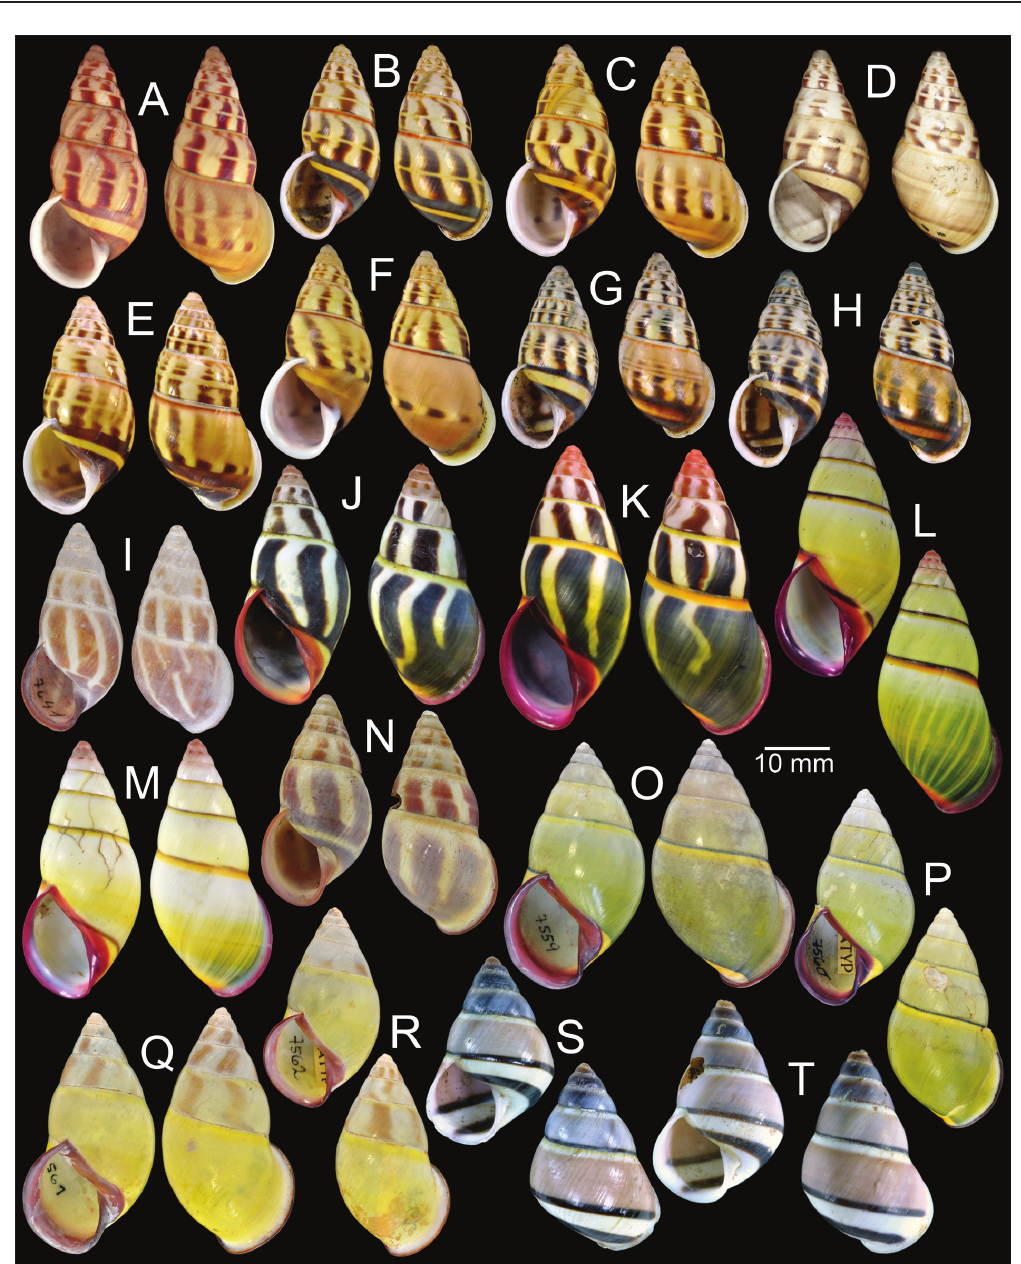
Fig. 13. Shells of Amphidromus ( Syndromus ) spp. A−C . Amphidromus xiengensis Morlet, 1891. A . Lectotype (MNHN-IM-2000-5249). B . Specimen from Thailand (CUMZ 7050). C . Specimen from Tam Chiang Dao, Chiangmai, Thailand (CUMZ 7034). D−F . Amphidromus xiengensis var. “ clausus ” Pilsbry, 1900. D . Lectotype (ANSP 31496). E . Specimen from Ban Na Deauy, Luang Phrabang, Laos (CUMZ 7036). F . Specimen from Pha Tang, Prayao, Thailand (CUMZ 7052). G–H . Amphidromus xiengensis var. “ multifasciata ” Fulton, 1896 from Phu Nang National Park, Phayao, Thailand (CUMZ 7038). I−M . Amphidromus fuscolabris Möllendorff, 1898. I . Holotype (SMF 7641). J−M . Specimens from Ban Phon, Sekong, Laos (CUMZ 7041–7042). N . Amphidromus eudeli Ancey, 1897, syntype from Binh Dinh, Annam (RBINS 617427). O–P . Amphidromus haematostoma Möllendorff, 1898. O . Lecto- type (SMF 7559). P . Paralectotype (SMF 7560). Q–R . Amphidromus haematostoma var. “ varians ” Möllendorff, 1898. Q . Lectotype (SMF 7561). R . Paralectotype (SMF 7562). S–T . Amphidromus xiengkhaungensis sp. nov. S . Holotype (CUMZ 7045). T . Paratype (CUMZ